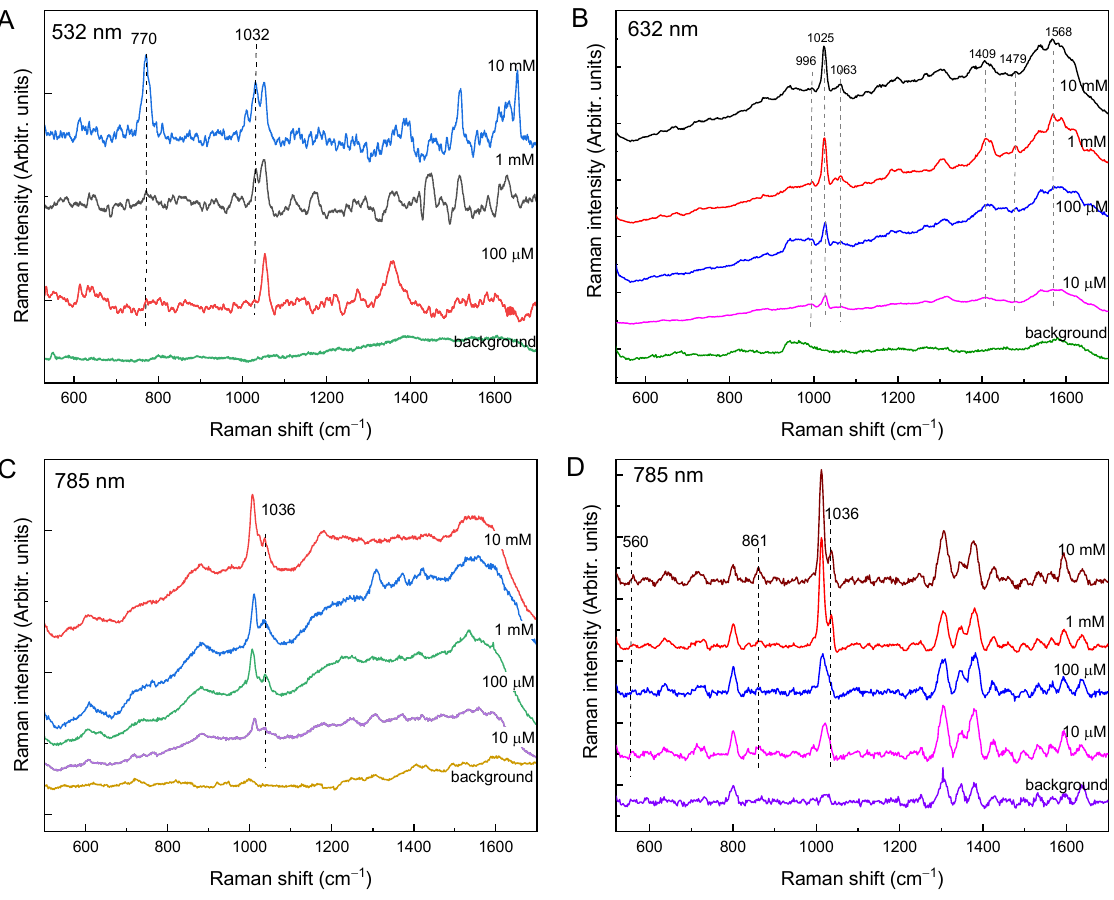
Figure 3. SERS spectra of different glyphosate concentrations: ( A ) with Ag NPs at 532 nm excitation; ( B ) with Au NPs at 632 nm excitation; ( C ) with Au NPs at 785 nm excitation; ( D ) with Au NPs at 785 nm excitation (baseline corrected; portable Raman).